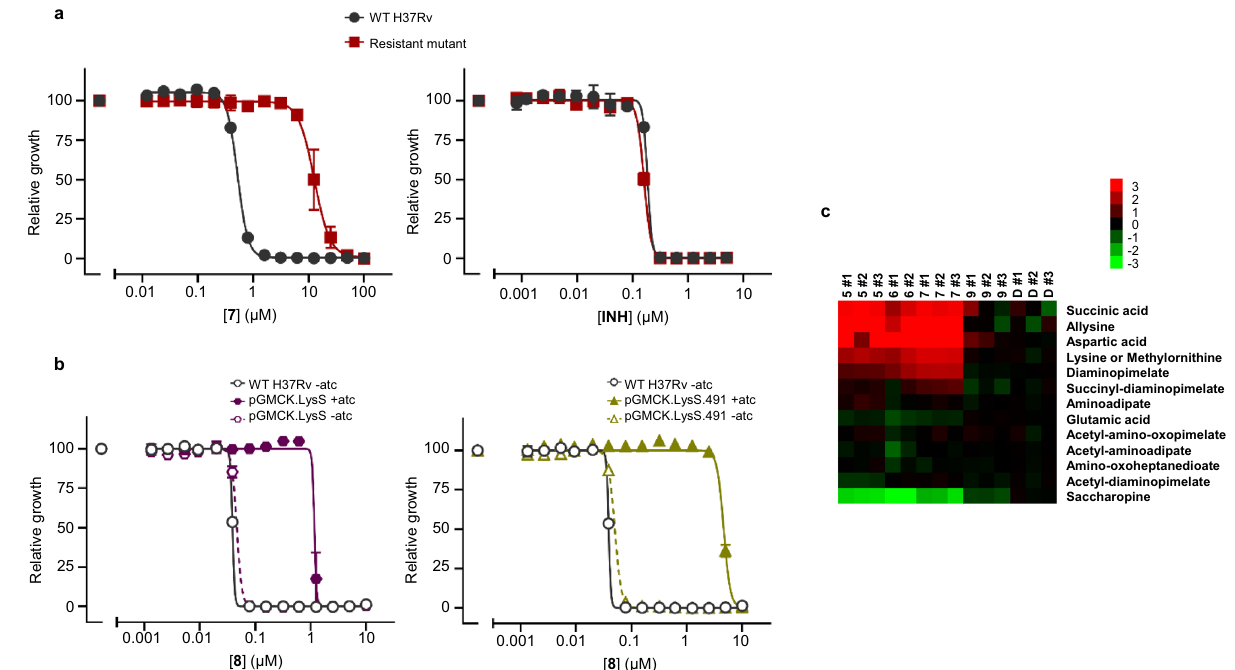
Fig.4|Studiestoexplorethecellularmechanismofaction.a Aresistantmutant was isolated against 7 , resistance was con fi rmed by looking at sensitivity over a concentrationrangecomparedtoparentalH37Rvforboth 7 andtheunrelateddrug isoniazid. b Impact of TetON overexpression of either wild-type (WT) LysRS or mutant LysRS.491 on sensitivity to 8 ±anhydrotetracycline (ATc), for comparison the impact of 8 on H37Rv is also shown. For a , b , graphs are representative data fromoneoftwoindependentexperimentseachrunintriplicatepresentedasmean values±standard deviation. c Metabolomic analysis of cells treated with three